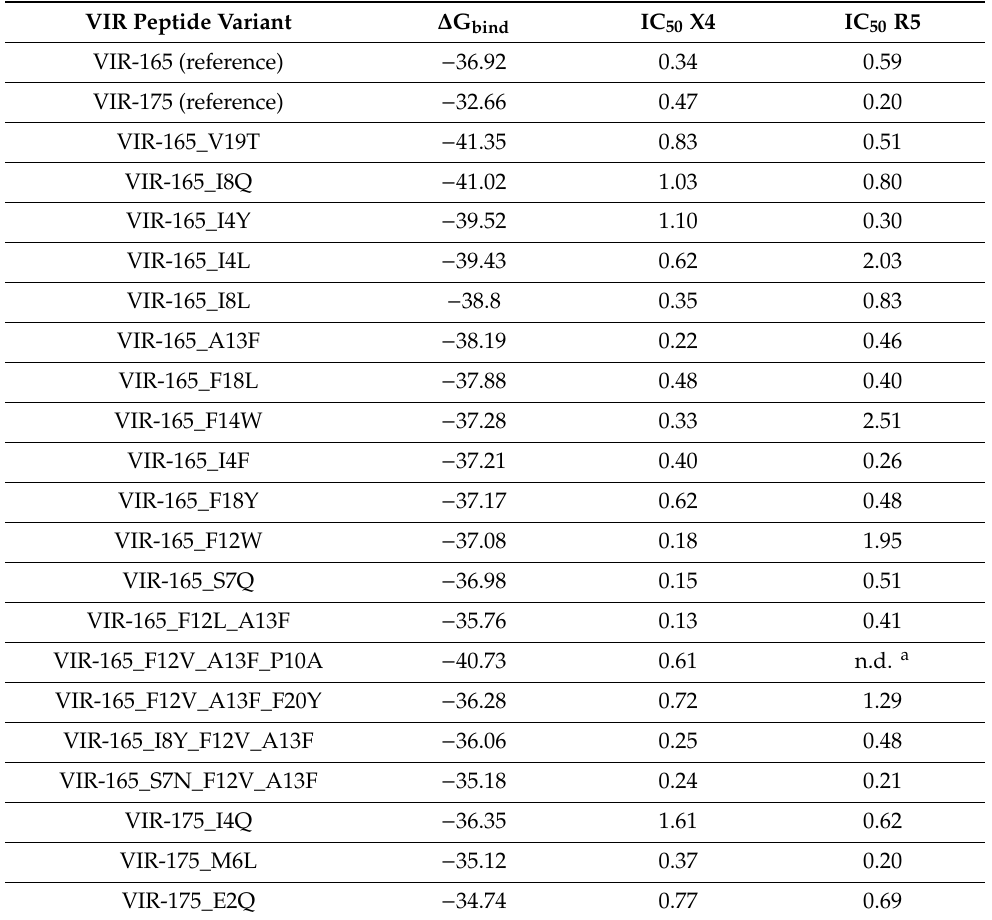
Table 1. Predicted binding free energies (kcal / mol) and experimental IC 50 values ( µ M) for VIR-165, VIR-175 and their variants selected through the virtual screening (VS) study of Venken and co-workers. IC 50 values obtained using X4-tropic and R5-tropic human immunodeficiency virus type 1 (HIV-1) virus are reported as IC 50 X4 and IC 50 R5,